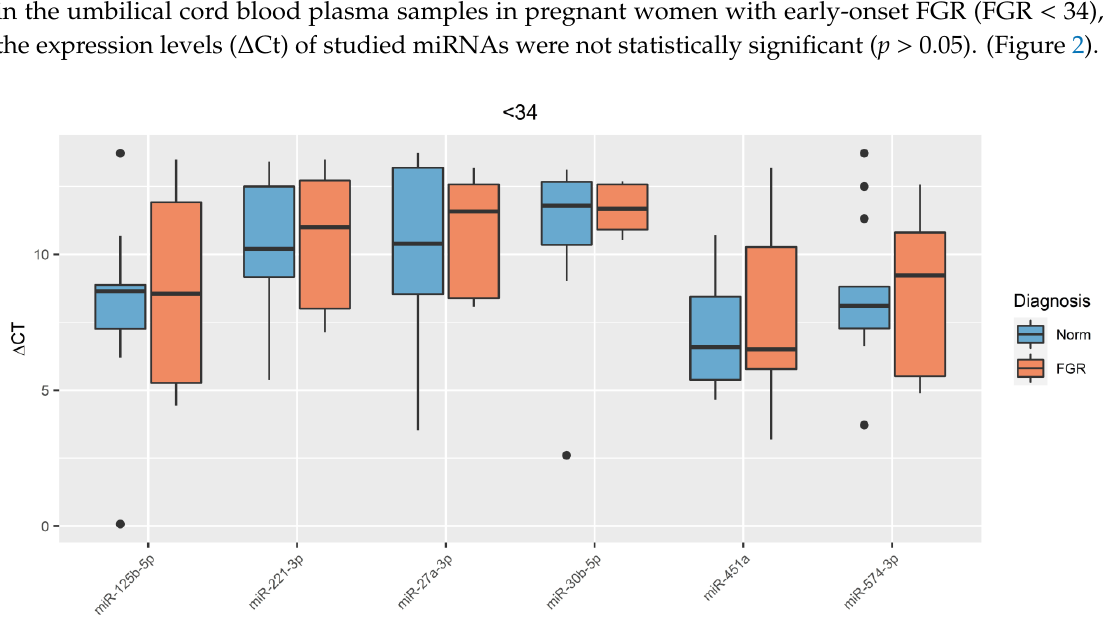
Figure 2. Comparative analysis of expression levels for miR-27a-3p, miR-30b-5p, miR-125b-5p, miR-221-3p, miR-451a, and miR-574-3p in umbilical cord blood plasma in pregnant women with early-onset FGR (FGR < 34). The box diagram shows the medians of ∆ Ct values, the first and third quartiles, and the edges of the statistically significant sample, and the dots denote the emissions. The lower the value of ∆ Ct, the higher the level of expression of studied miRNA.